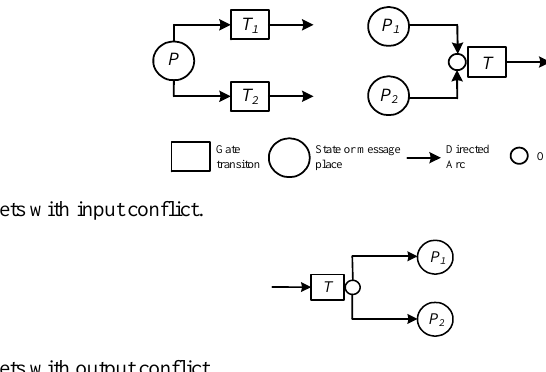
Fig. 4. Petri nets with output